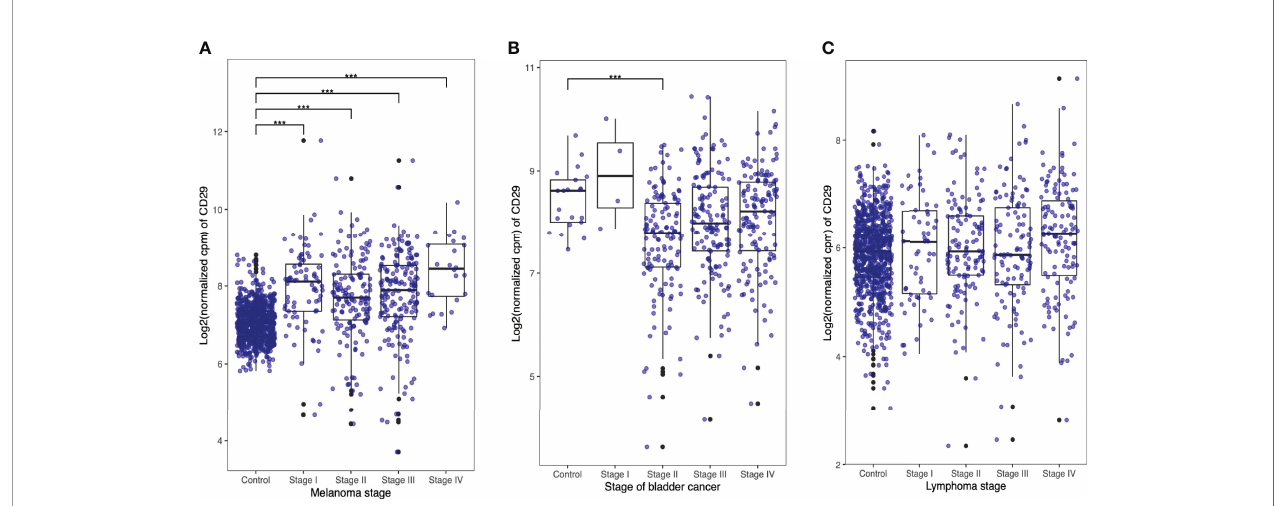
FIGURE 7 | Human tumor cells express CD49b and CD29. RNA-Seq data from healthy tissues (control) was downloaded from the Genotype-Tissue Expression (GTEx) (v8) project (https://gtexportal.org). Differential gene expression was assessed using R/edgeR by applying trimmed mean of M-values (TMM) normalization. Respective cancer and normal tissue sample data were normalized together to avoid composition bias. Expression of genes CD29 (ENSG00000150093) and CD49b (ENSG00000164171) was evaluated in melanoma (A) , bladder (B) , and lymphoma (C) cancer